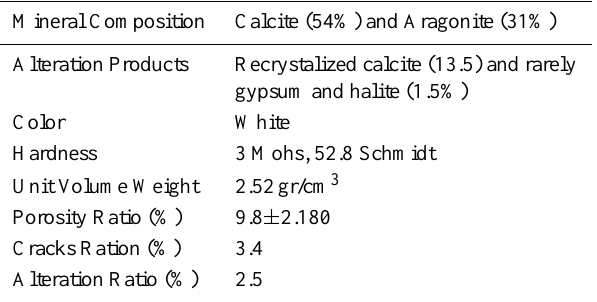
Table 1. Modal mineralogical composition and physical properties of white-colored travertine in Anitkabir.